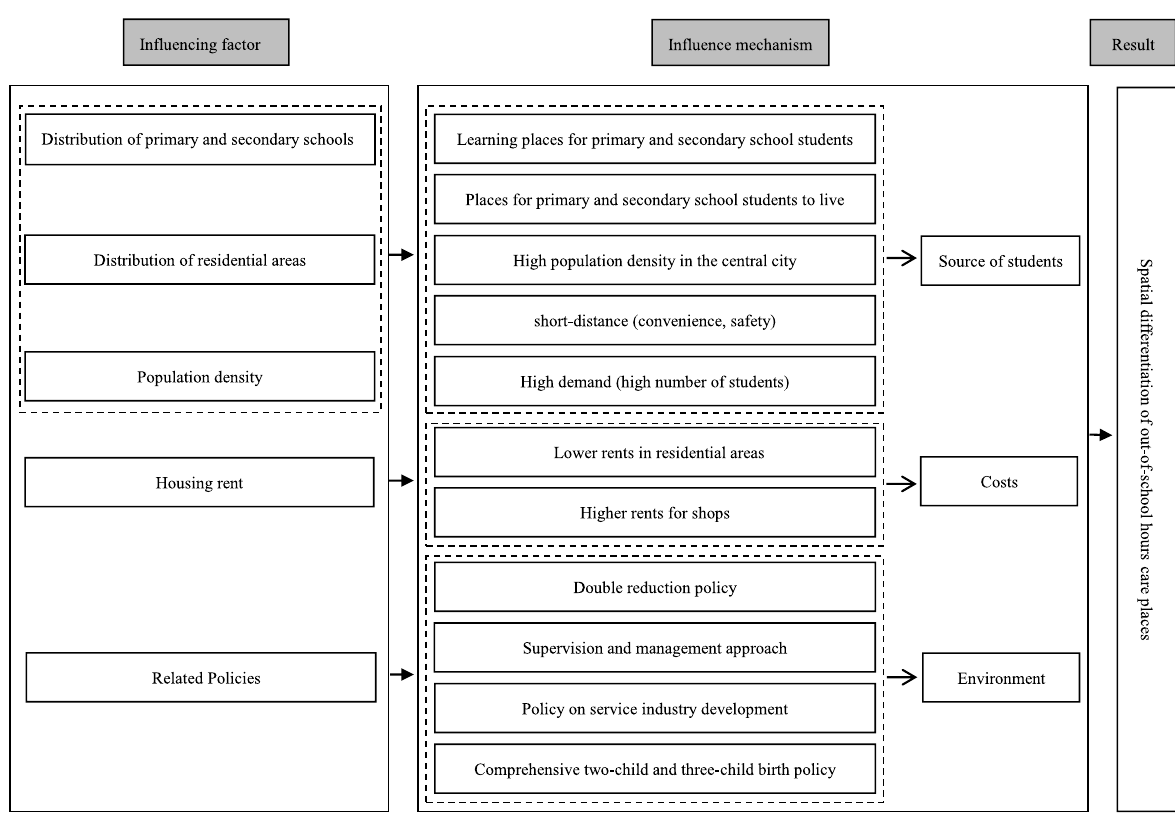
Fig. 6 Influencing factors of the spatial pattern of out-of-school hours care places in